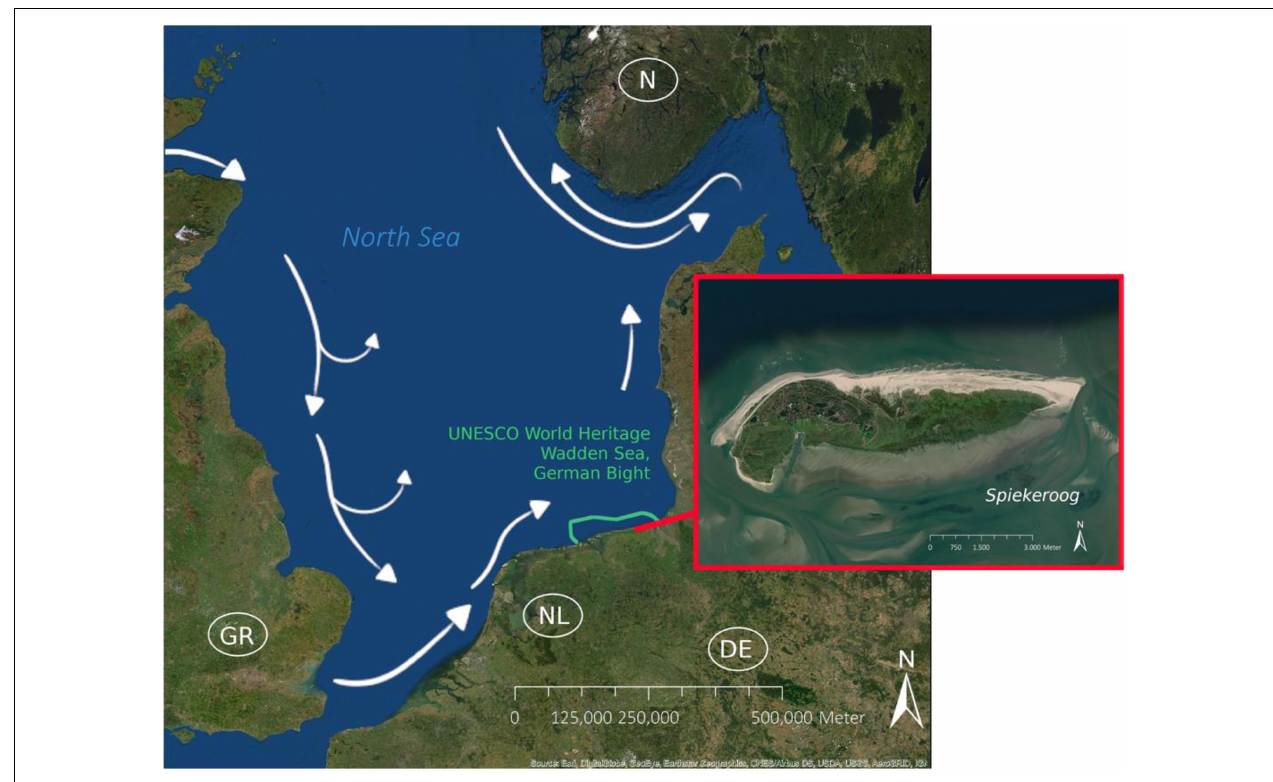
FIGURE 2 | North Sea/Spiekeroog. The island of Spiekeroog (53.77 ◦ N, 7.73 ◦ E) is located in the German Bight (southern North Sea). The North Sea is a marginal sea connected with the Atlantic Ocean via the Norwegian Sea and the English Channel. Entering from the Atlantic, a Kelvin wave created by tidal effects runs southward primarily along the British east coast and synchronizes with the tides running in via the English Channel and the river run-offs. This induces a counter-clockwise current regime in the North Sea, with a west-to-east flow is forced within the southern North Sea that is fueled by strong westerly winds (Mathis et al., 2015). This primary direction of flow is almost continuous and rarely interrupted by regional weather phenomena (Stanev et al., 2019). Spiekeroogs back-barrier tidal flat is part of the German East Frisian Wadden Sea, renowned as UNESCO World Heritage